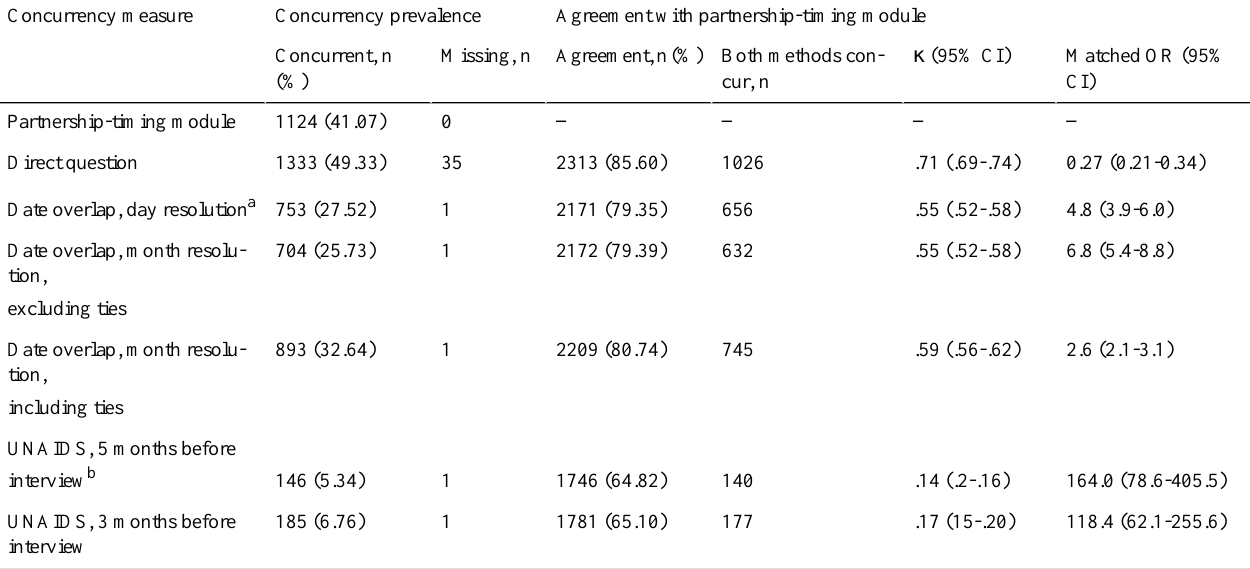
Table 1. Individual-level concurrency by partnership-timing module and alternative measures of concurrency among 2737 men who have sex with men.